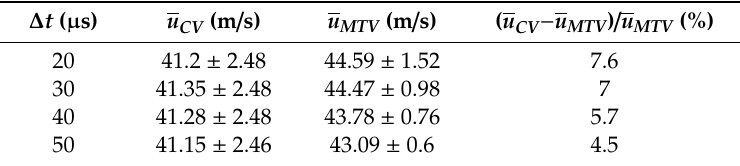
Table 8. Average velocities u CV and u MTV with estimated uncertainties, and relative deviation between u CV and u MTV calculated for the image data of Figure 17. The uncertainty range has a confidence level of